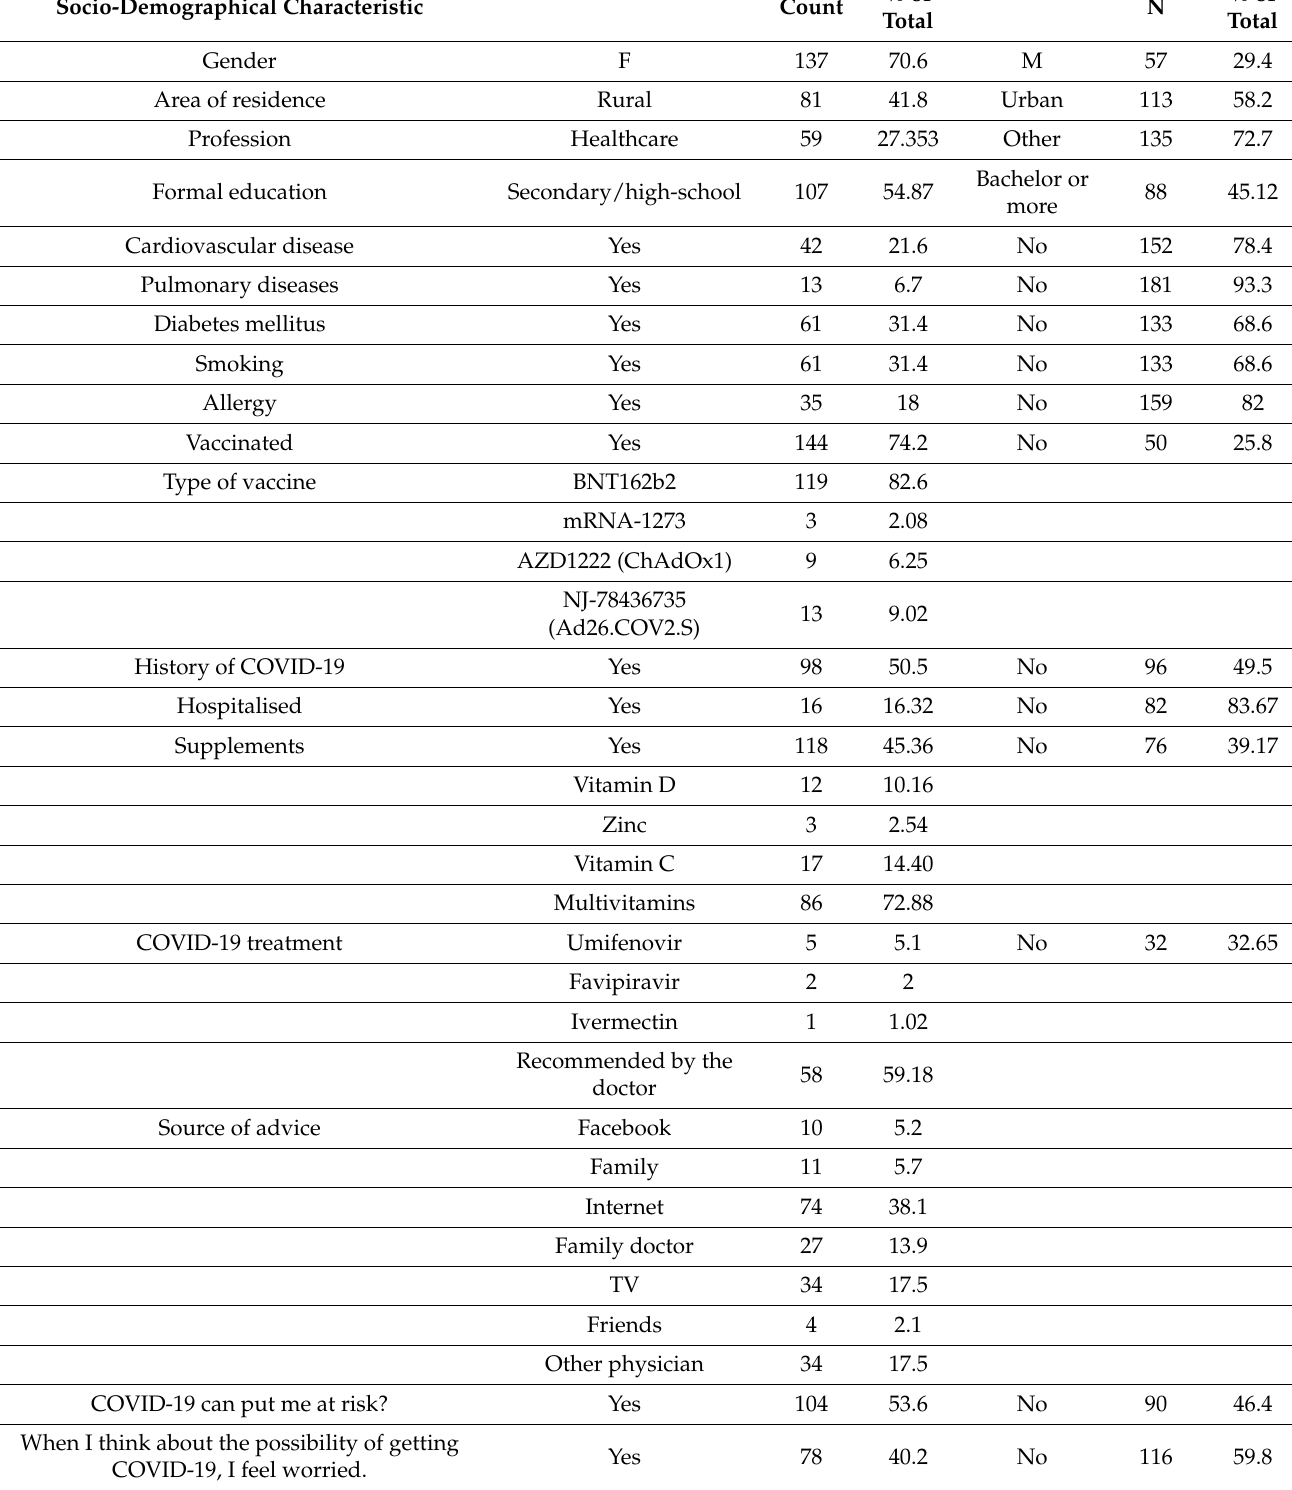
Table 1. Characteristics of the study